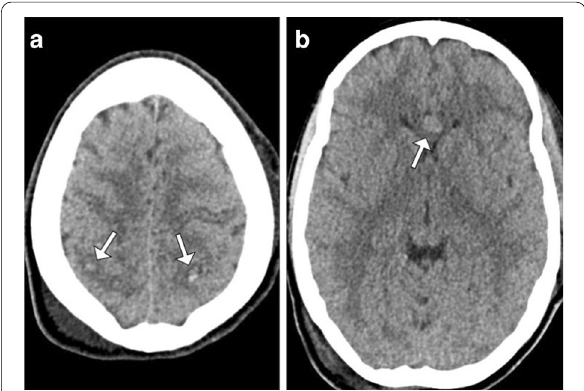
Fig. 2 A case showing microhemorrhages as seen on CT. Axial native CT scan images at the level of the centrum semiovale and the basal ganglia of a 16-year-old polytraumatised female patient acquired on postoperative day 11 after hospital admission. Multiple subcortical punctiform hyperdensities presumably representing microhemorrhages are seen bilaterally in the subcortical white matter ( a ), and a larger hyperdensity is seen in the genu of the corpus callosum ( b )